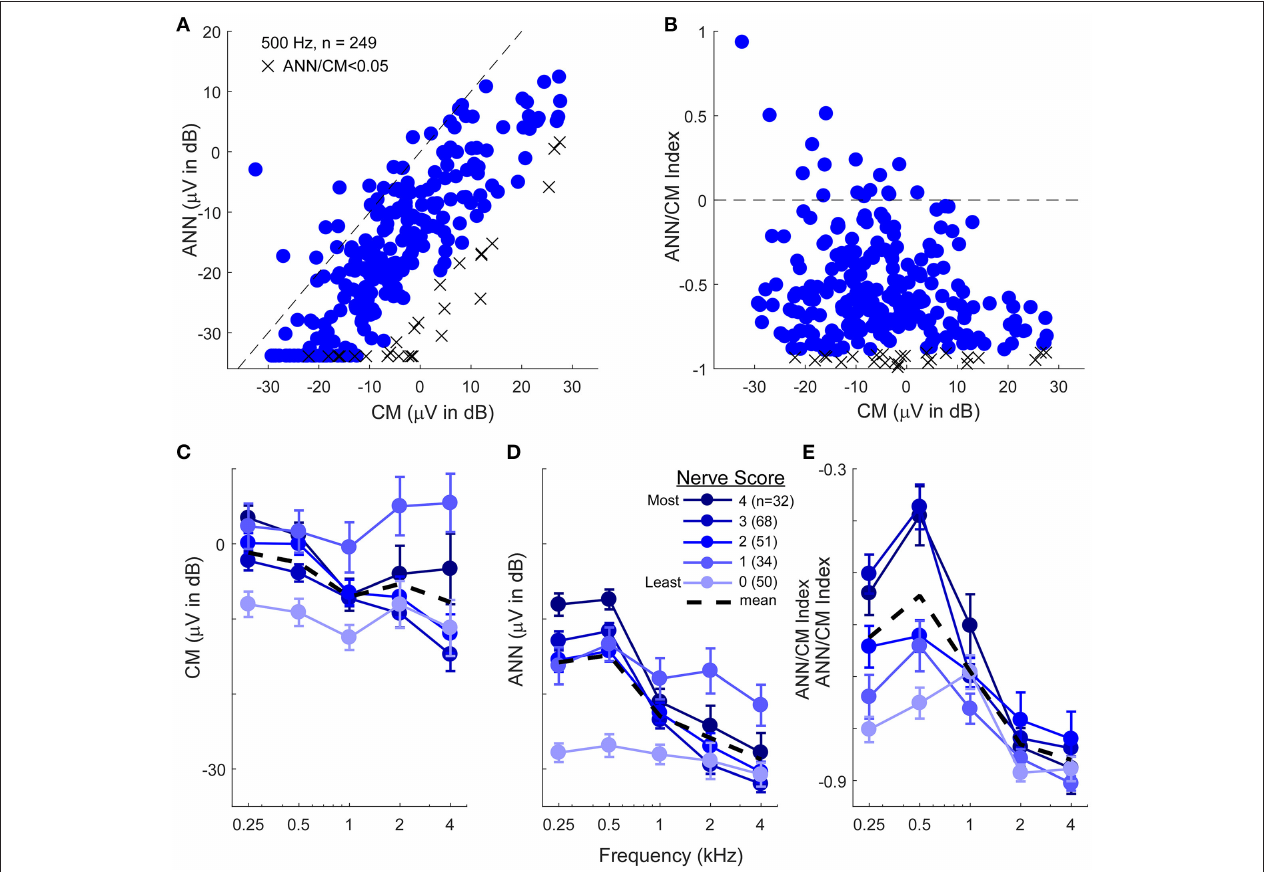
FIGURE 11 | The CM and ANN in human CI subjects. (A) In 249 subjects with significant responses (see section Methods) to 500Hz tone bursts at 90 dB HL the ANN amplitude was generally smaller than the CM (below the line of equality, dashed) but the two were positively correlated ( r 0.75, p < 0.001). Symbols with an X = had an ANN/CM ratio < 0.05. (B) The ANN/CM index of the same subjects. On this scale an index of 1 is all CM, 0 is equal amount of CM and ANN, and 1 is all ANN. − Usually the CM was greater than the ANN, although in a number of cases they were nearly equal, and in a few the ANN was larger than the CM (C–E). The CM (C) , ANN (D) , and ANN/CM index (D) as a function of frequency and with the parameter of “nerve score,” which is a subjective scaling of the neural activity in each cases based on visual observation of the CM and ANN. There was no trend for the subjective nerve activity to reflect the size of the CM, in contrast, the size of the ANN and the ANN/CM index reflected the nerve activity. Both also showed low-pass filtering of similar to that in gerbil. The responses included for each frequency had to be significant (see section Methods) so the numbers of cases differ by a small amount for 250–1,000Hz ( > 80% of cases have significant responses to these frequencies) but are fewer to 2 and 4kHz (43 and 26%, respectively). Errors bars in (C–E) are standard